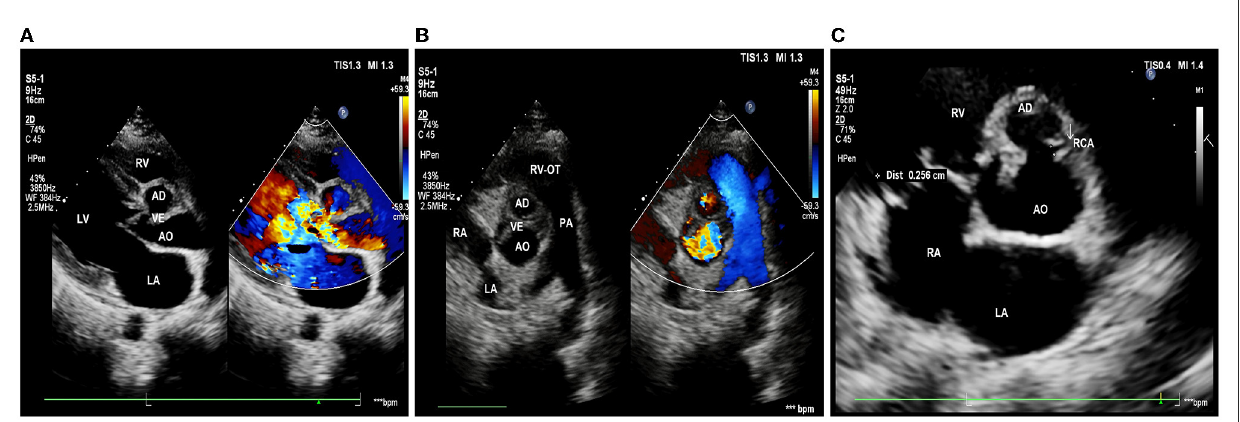
FIGURE1 Pre-operative echocardiography. (A) Long-axis view of the left ventricle shows aortic valves thickening and flail motion, and color Doppler shows massive aortic regurgitation. (B) Short-axis view of the great arteries shows that the bulge in the aortic root communicates with the aorta, with vegetations in the aortic valve. (C) The right coronary artery (white arrow) is restrictive; LA, left atrium; LV, left ventricle; RV, right ventricle; AO, aorta; RVOT, right ventricular outflow tract; PA, pulmonary artery; RCA, right coronary artery; AD, aortic disease; and VE, valvular excrescence.